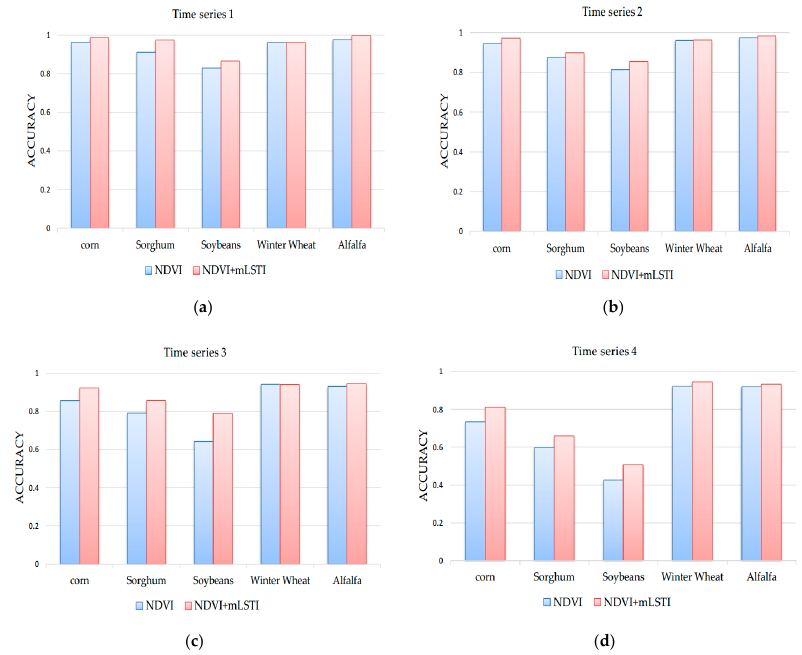
Figure 7. Comparison of the classification accuracies of crops based on short time series: ( a ) time series 1, ( b ) time series 2, ( c ) time series 3, and ( d ) time series 4.